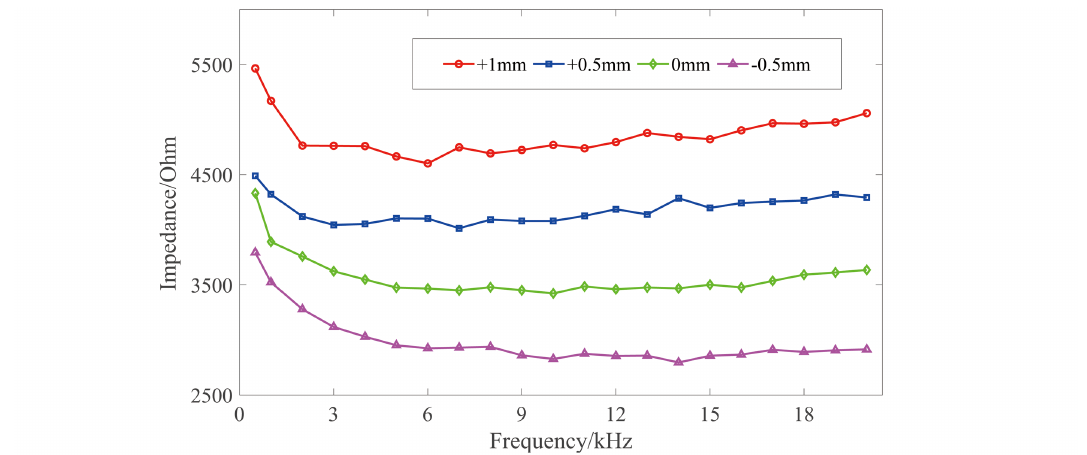
Figure 9. The impedance of the file at different position from apical foramen varying with